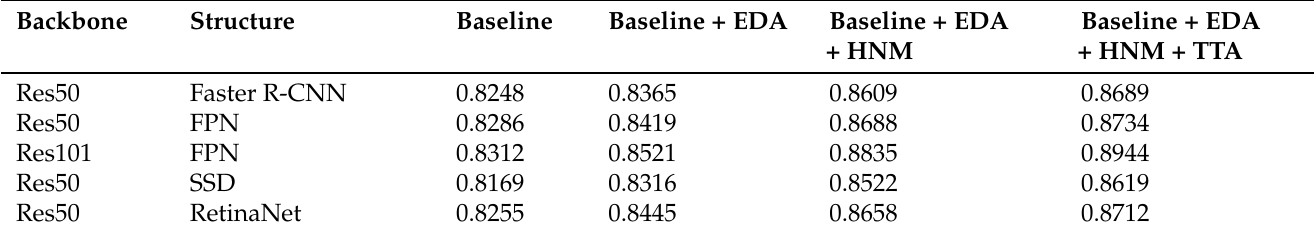
Table 3. The mAP accuracy while using different backbone structures.